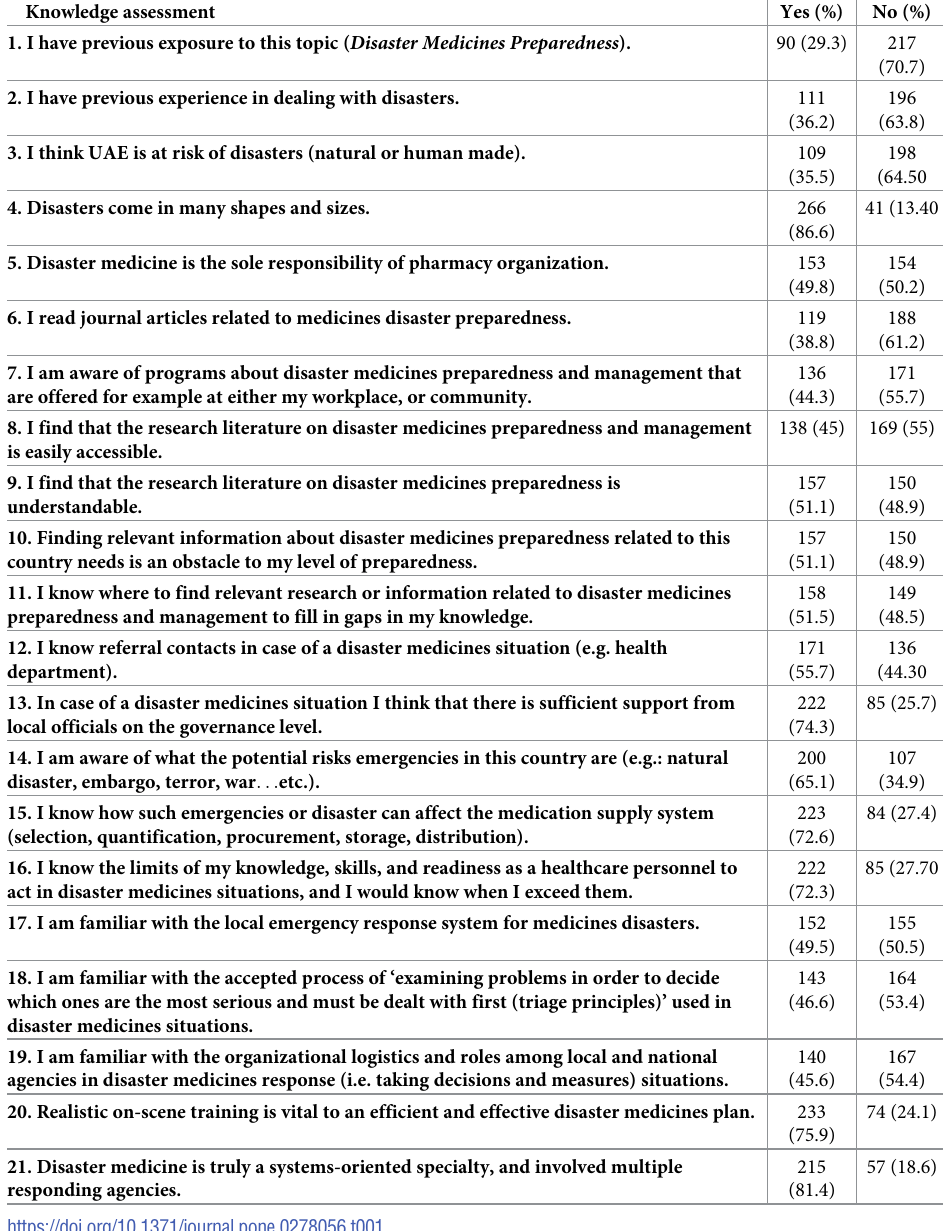
Table 1. Knowledge among HCPs on medicine disasters. Knowledge